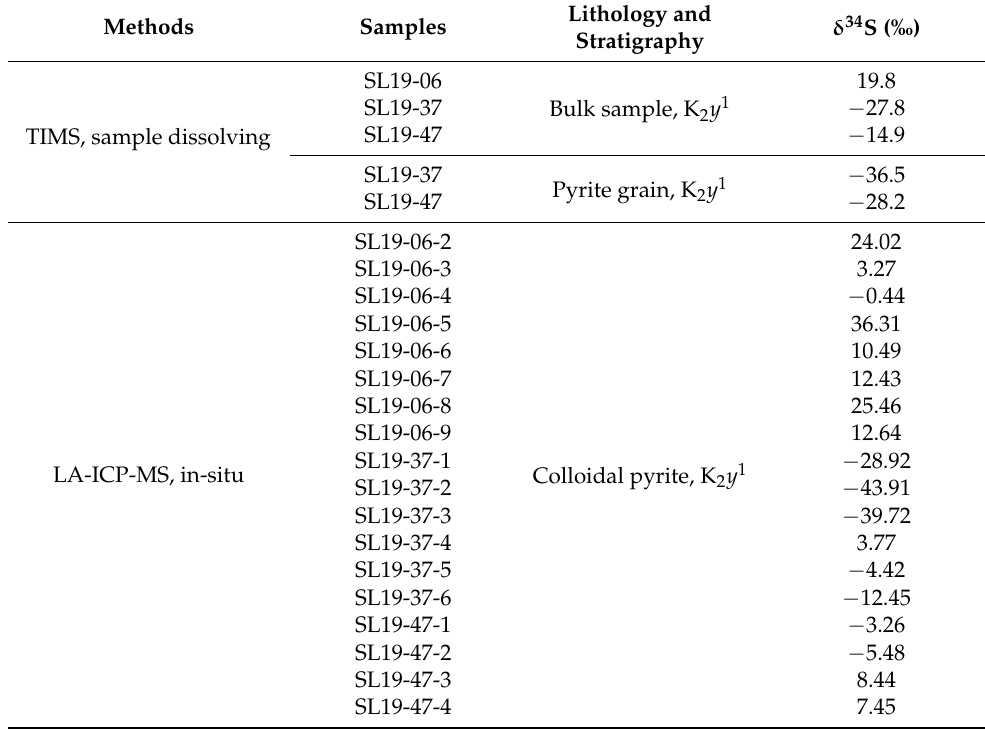
Table 3. S isotopic compositions of pyrite from the Lower member of Yaojia